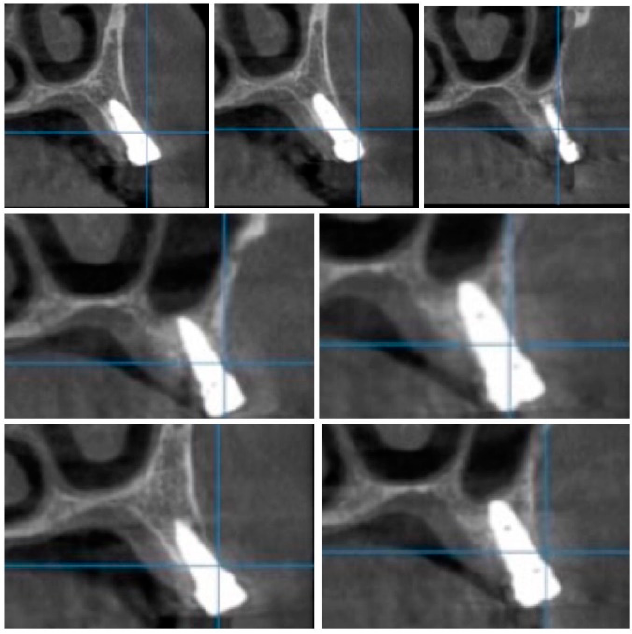
Figure 11. Random CBCT images with pulse electromagnetic healing caps in position.